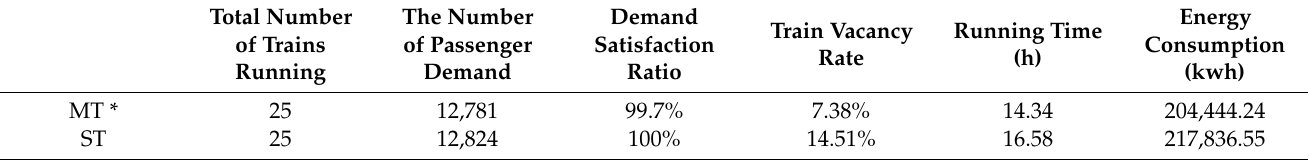
Table 15. Comparison of metrics under scenario